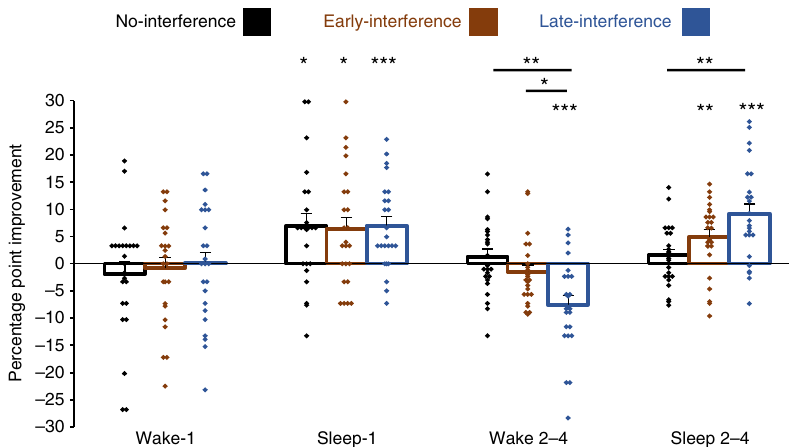
Fig. 5 Performance improvement scores in experiment-2. The mean percentage-point improvement is shown for each condition grouped by the retention period: Wake-1 depicts the performance change across the fi rst day of consolidation, Sleep-1 depicts the performance change across the fi rst night of consolidation, Wake 2 – 4 depicts the average improvement scores over the three reconsolidation waking periods, and Sleep 2 – 4 depicts the average improvement scores over the three reconsolidation sleeping periods. The same 24 starlings completed each condition. Asterisks directly above the bars indicate signi fi cant performance changes for that speci fi c condition and retention period. Asterisks above connecting lines indicate signi fi cant differences in performance changes between conditions within a given retention period (* P < 0.05; ** P < 0.01; *** P < 0.001 after Holm – Bonferroni corrections). Error bars show standard error of the mean. Dot plots show individual percentage point improvement scores across the given retention period